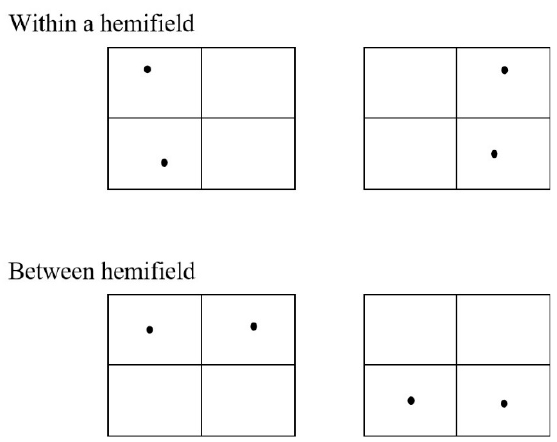
Figure 4. Examples of four presentations of the target ball.